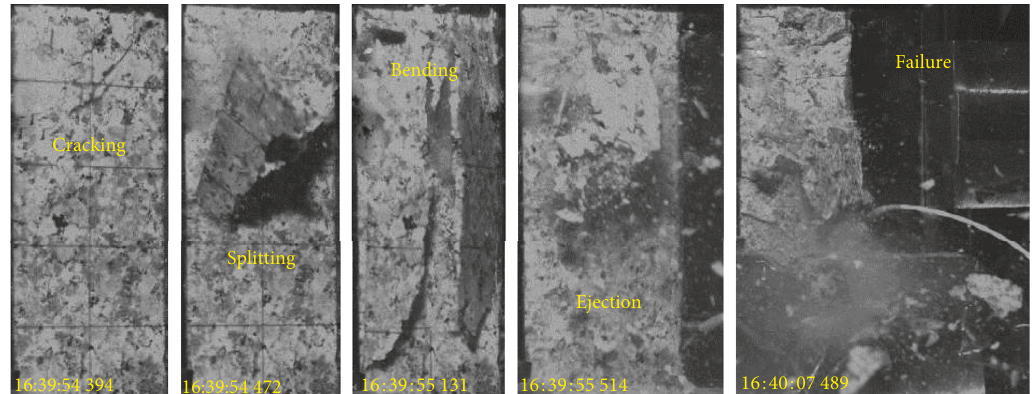
Figure 2: Failure process of the granite in the strain burst test captured by the high-speed camera. The number under each photograph shows the time (h: min :s